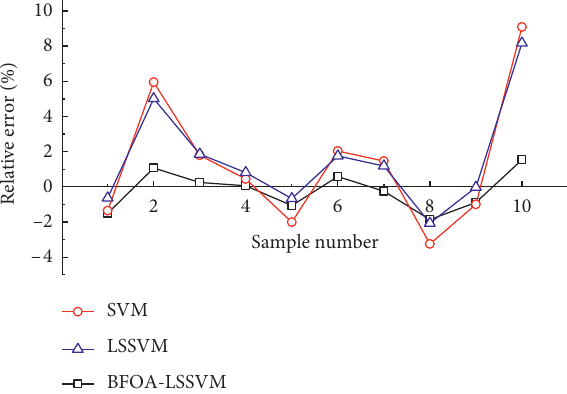
Figure 11: Model computing ability